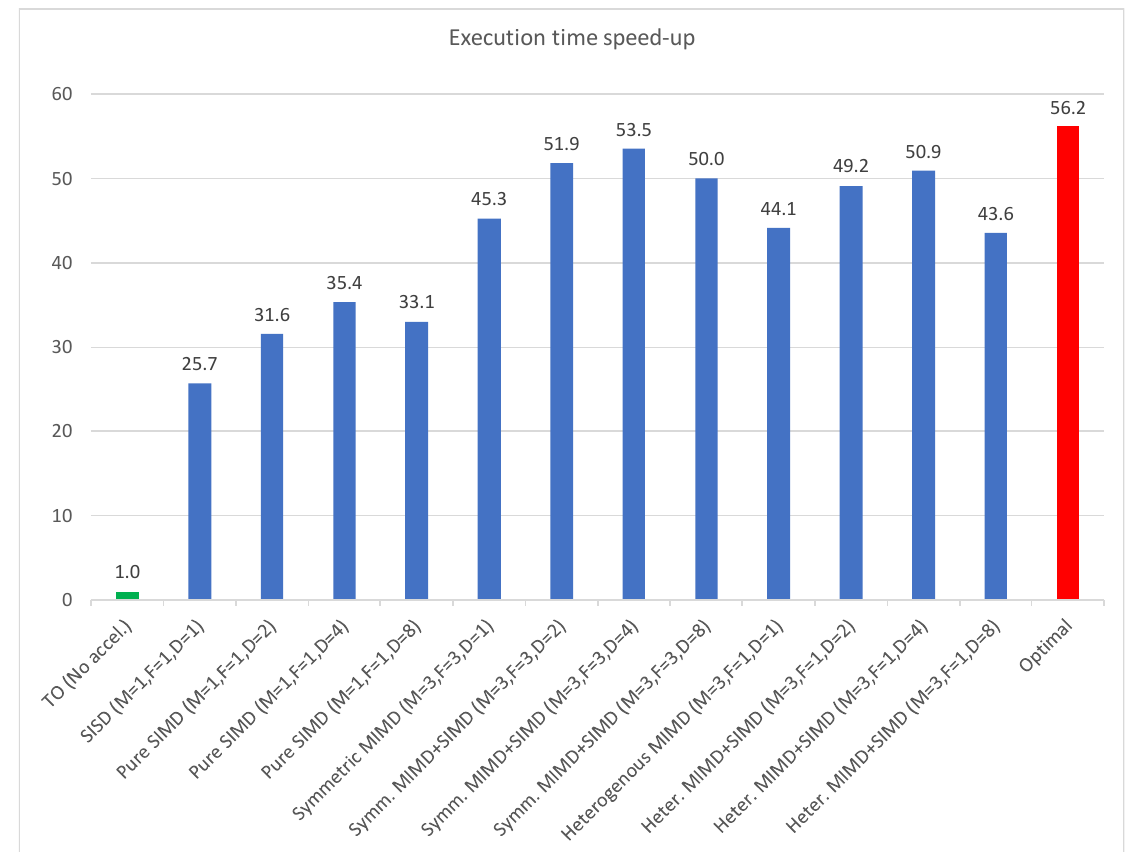
17 of 22 Figure 15. Absolute execution time [s] of the best performing accelerated configuration and of the non-accelerated T0 core, per layer.